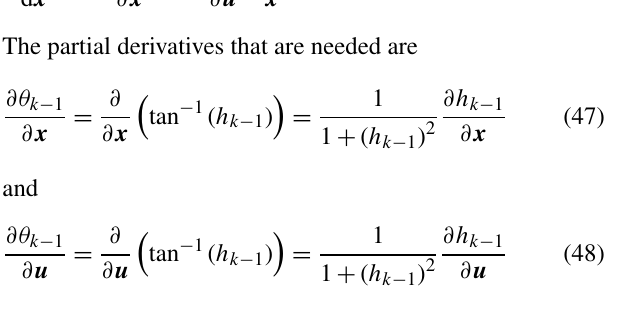
Figure 3. Transformation of coordinates of the control points in a set of generalized coordinates, described by the lengths and angles of the links of a linkage chain representing the control